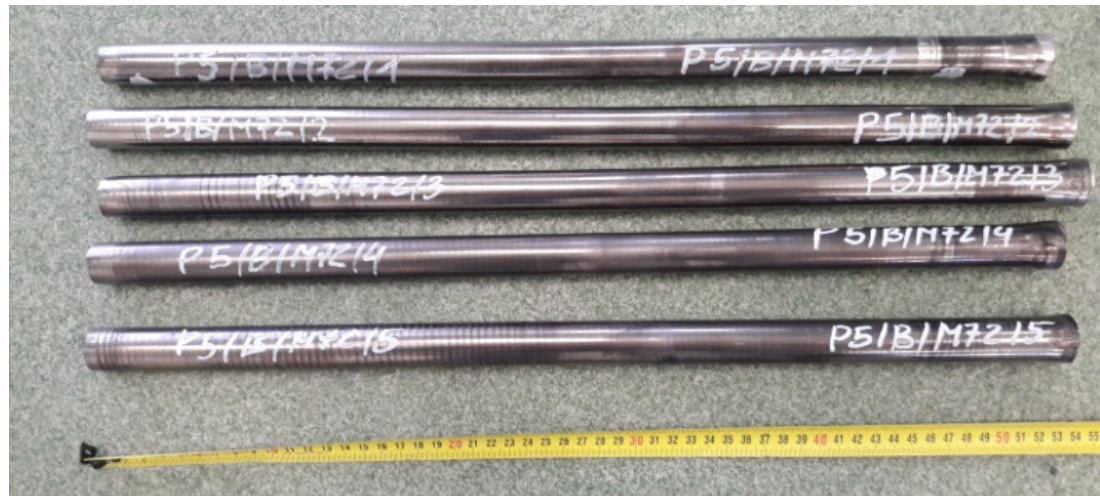
Figure 5. View of rods samples (WHA) after cold swaging.